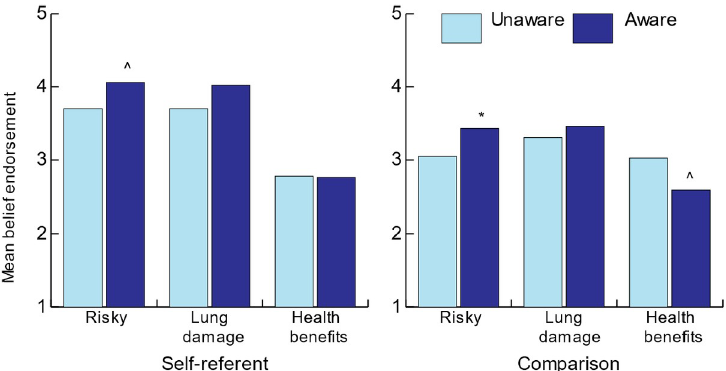
Fig 3. Mean belief endorsement differences in study two among participants who were unaware of the EVALI news compared to those who were aware. Number of unaware participants = 76 (n = 37 for self-referent wording and n = 39 for comparison wording). Number of aware participants = 276 (n = 135 for self-referent and n = 132 for comparison wording). Welch t-test implemented to account for unequal sample sizes, � p < .05 ^p = .07.